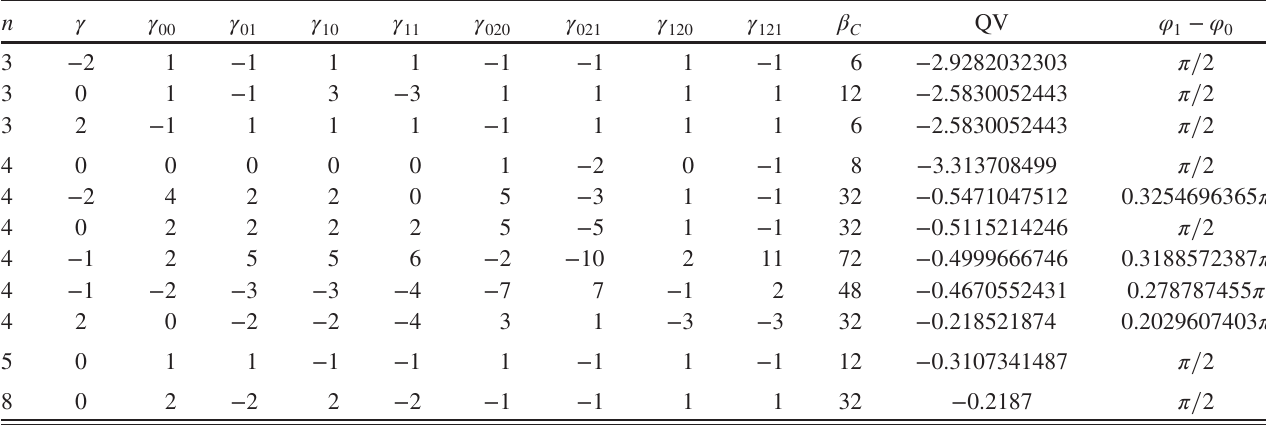
is the classical bound, QV is C σ ð i Þ φ ð i Þ σ ð i Þ ¼ cos φ ð i Þ x þ sin y , and k k k